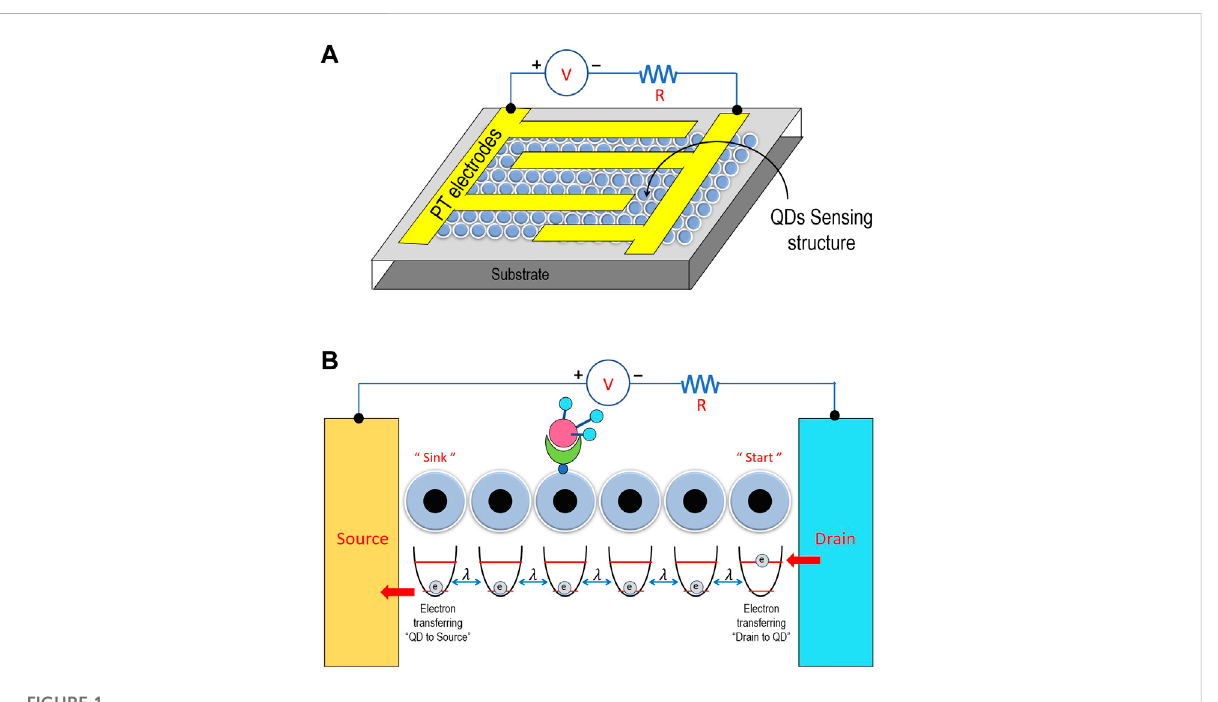
FIGURE 1 (A) Schematicofachemiresistivestructurewithplatinum(Pt)electrodesandPtheaterforgassensingmeasurements. (B) Schematicdiagramof a linear chain of N -coupled two-level systems (quantum dots (QDs)); that is, the QDs integrated into the sensing structures have been mainly synthesized by colloidal methods. The QD 4 th site is surfaced by using a functional group, which is used to detect the analyte.